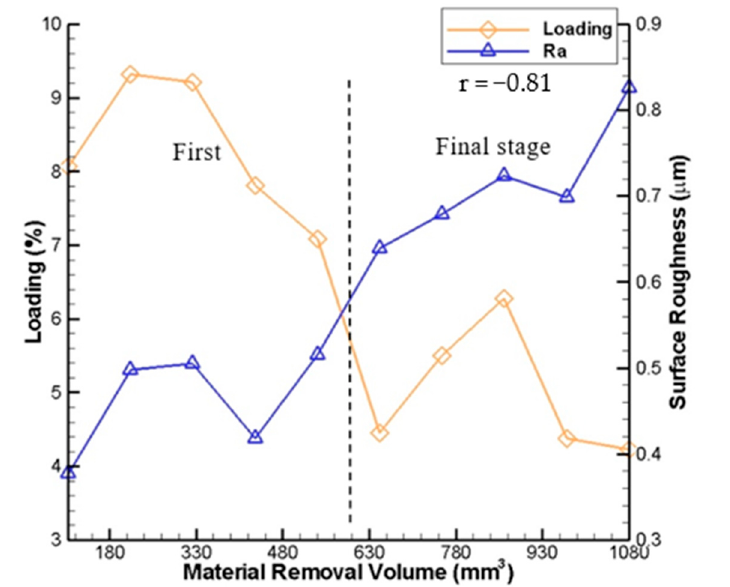
Figure 11. Comparison of measured wheel loading and measured surface roughness with material removal volume.